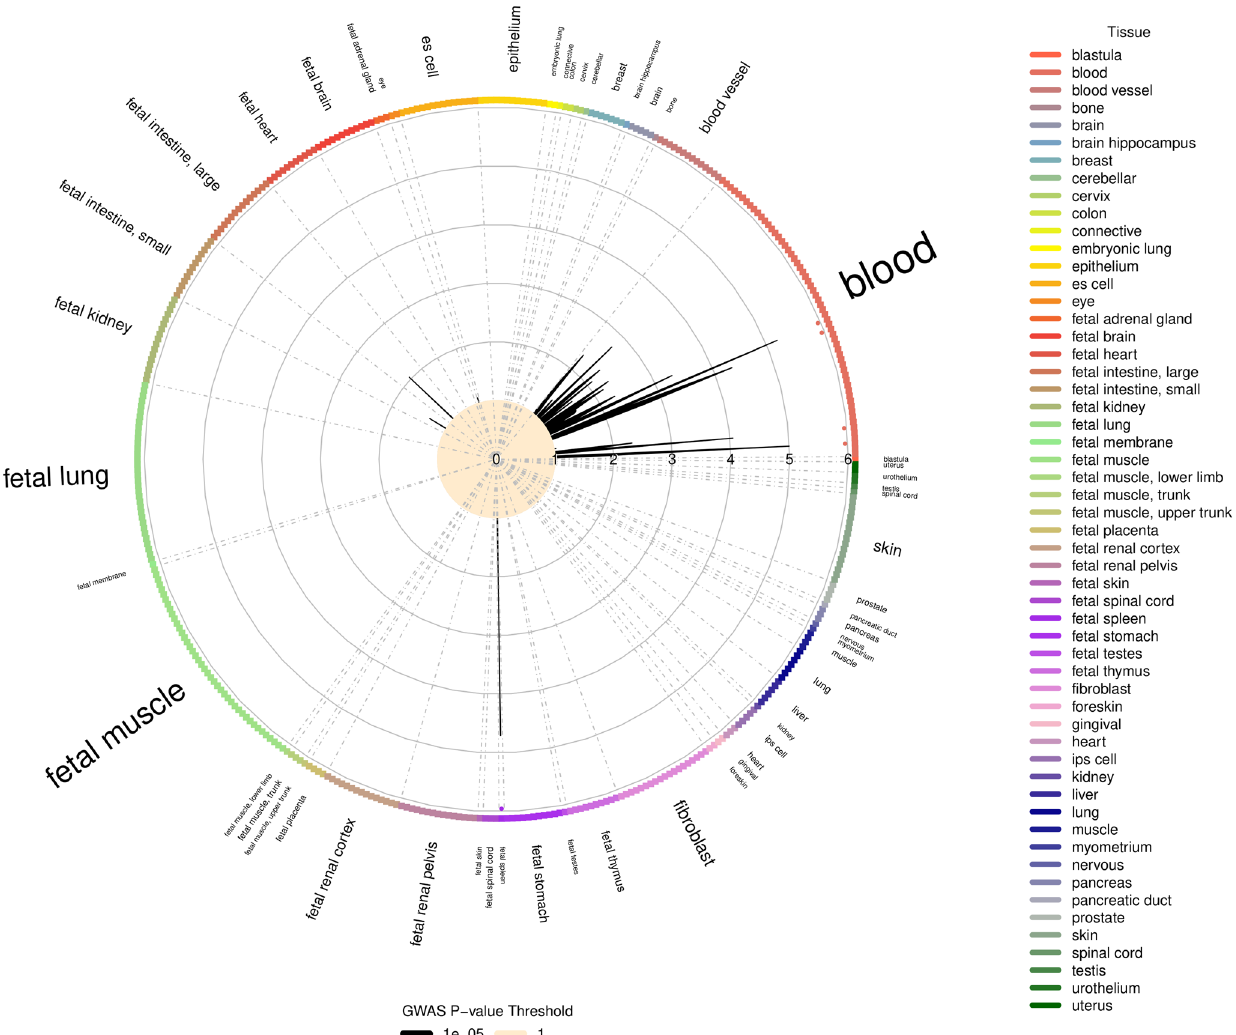
Fig. 4 GARFIELD functional enrichment analysis of the GWAS results accordingly with Sertoli cell-only phenotype. The radial axis represents the enrichment (OR) for each of the analysed cell types that are sorted by tissue along the outside edge of the plot. Boxes forming the edge are coloured by tissue. Enrichment is calculated for the GWAS P -value threshold P < 1E − 05. Dots in the inner ring of the outer circle denote signi fi cant GARFIELD enrichment after multiple-testing correction for the number of effective annotations and are coloured with respect to the tissue cell type tested (font size of tissue labels re fl ects the number of cell types from that